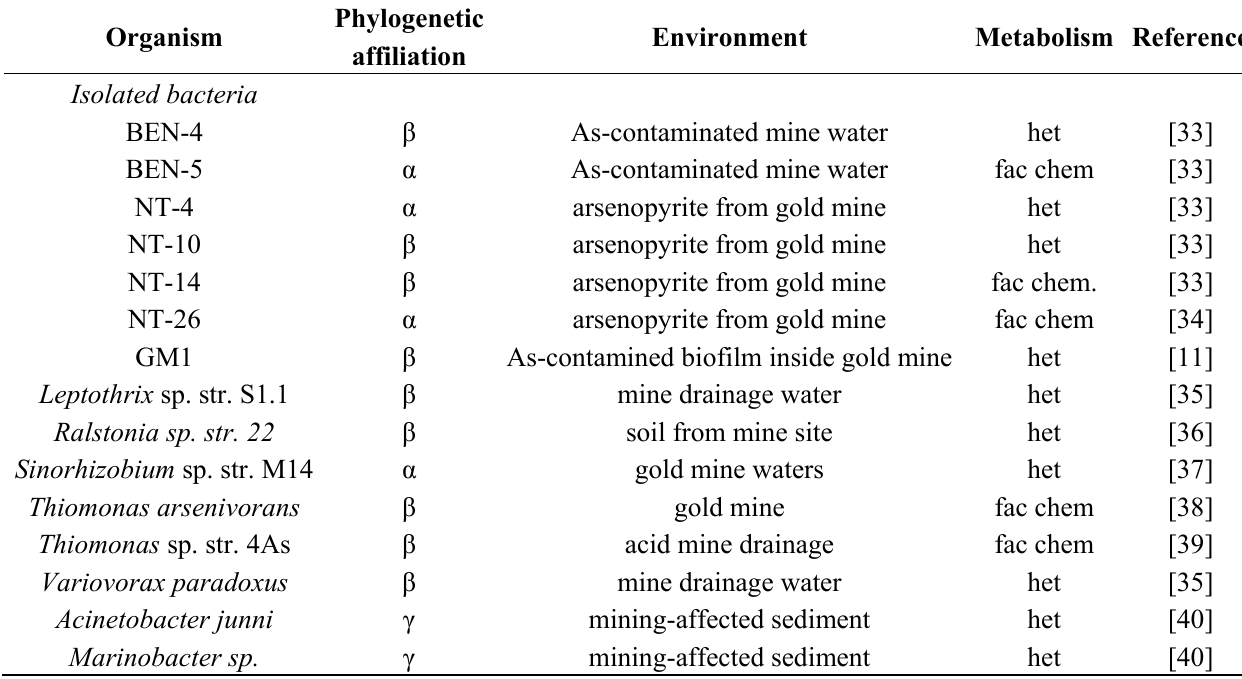
Table 2. Examples of isolated aerobic As(III)-oxidizing bacteria from mining-affected environments. Adapted and expanded from [30]. fac chem.: facultative chemolithoautotrophic; het: heterotrophic; α, β: Alpha-, Betaproteobacteria,